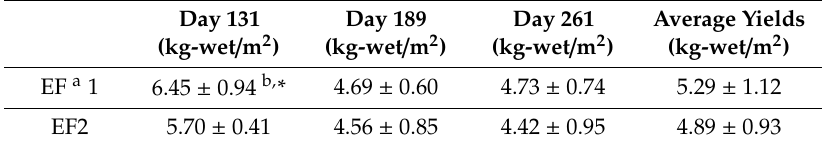
Table 1. Yields of green onion at experimental fields during cultivation experiments.